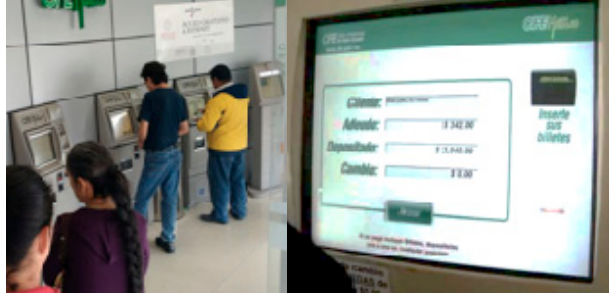
Figure 3. General overview and detailed closeup of the taxi ticketing kiosk interface in Monterrey airport, Mexico.